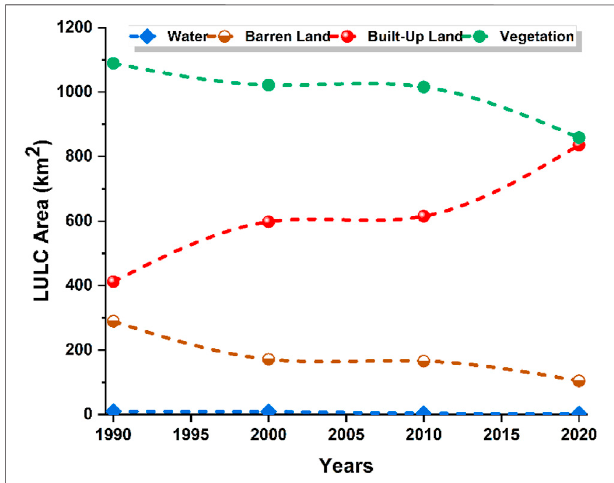
FIGURE 4 | Graphical presentation of LULC